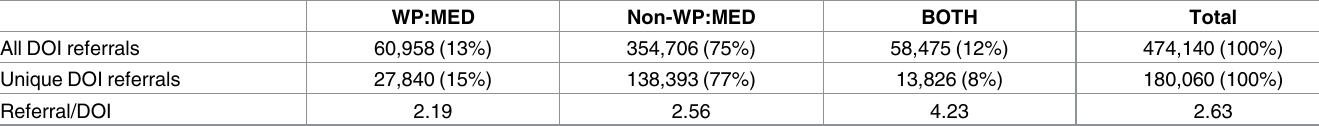
Table 8. AverageDOI citations, total referralsfrom DOI citations, and unique DOI citation referralsduring August